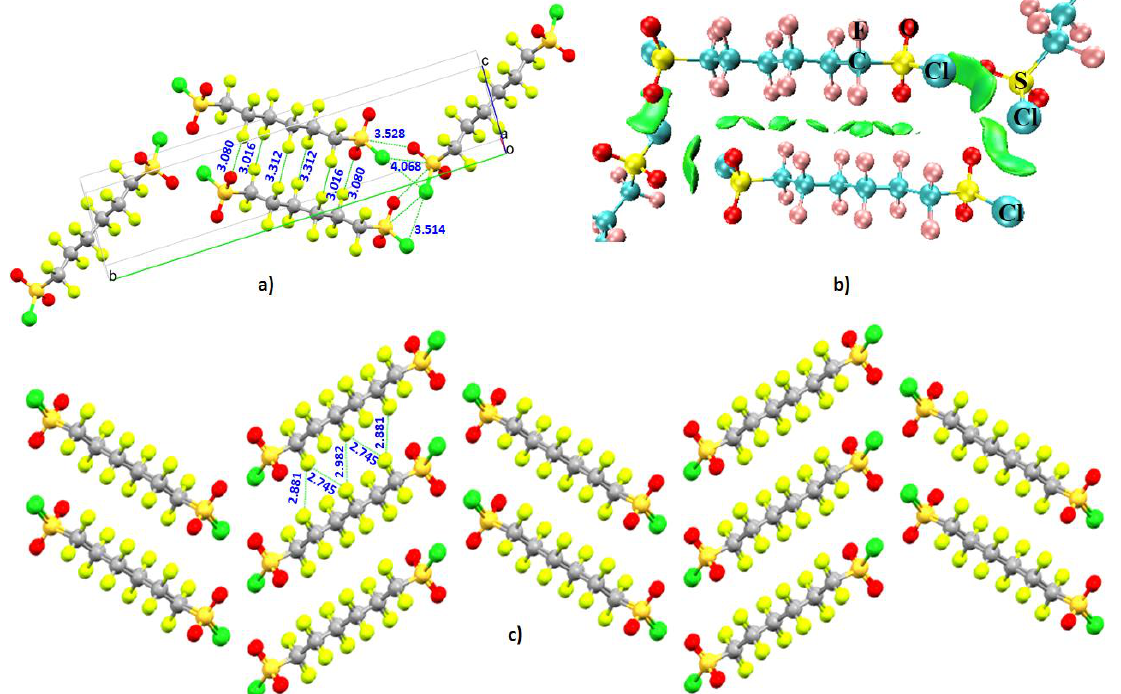
Figure 23. ( a ) The ball-and-stick model of the crystal structure of dodecafluorohexane-1,6-disulfonyl dichloride (CSD ref: TEWNUH). ( b ) IGM isosurface plot (isovalue = 0.005 a.u.), illustrating possible halogen-center intermolecular bonding scenarios. Selected bond distances are shown in Å. ( c ) An extended model of the crystal, showing the zigzag array in 3D.